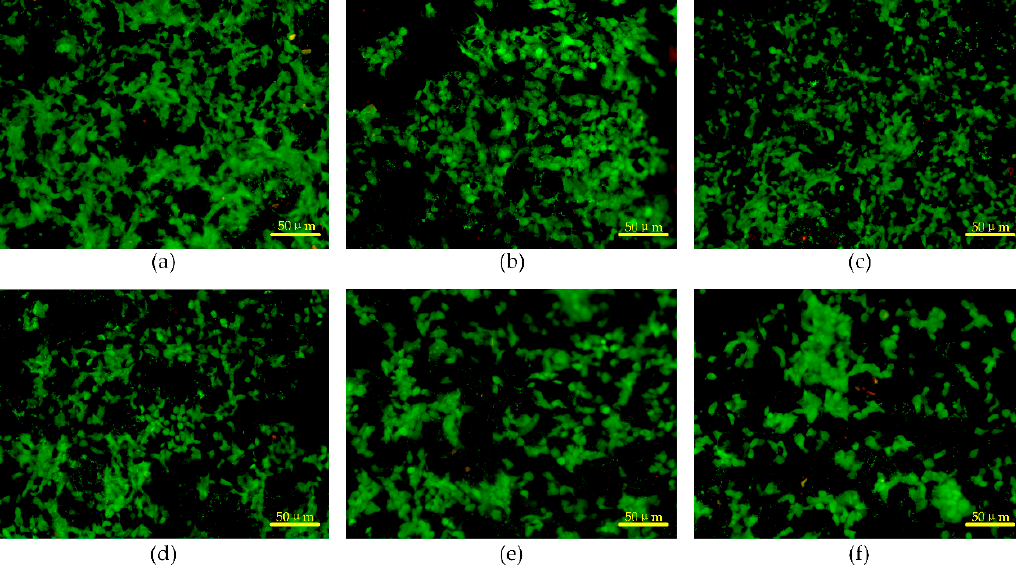
Figure 9. The result of cytotoxicity tests on ( a ) 1 wt%, ( b ) 2.5 wt%, ( c ) 4 wt%, ( d ) 5.5 wt%, ( e ) 7 wt%, and ( f ) 8 wt% MWCNT/PDMS composite sheets.